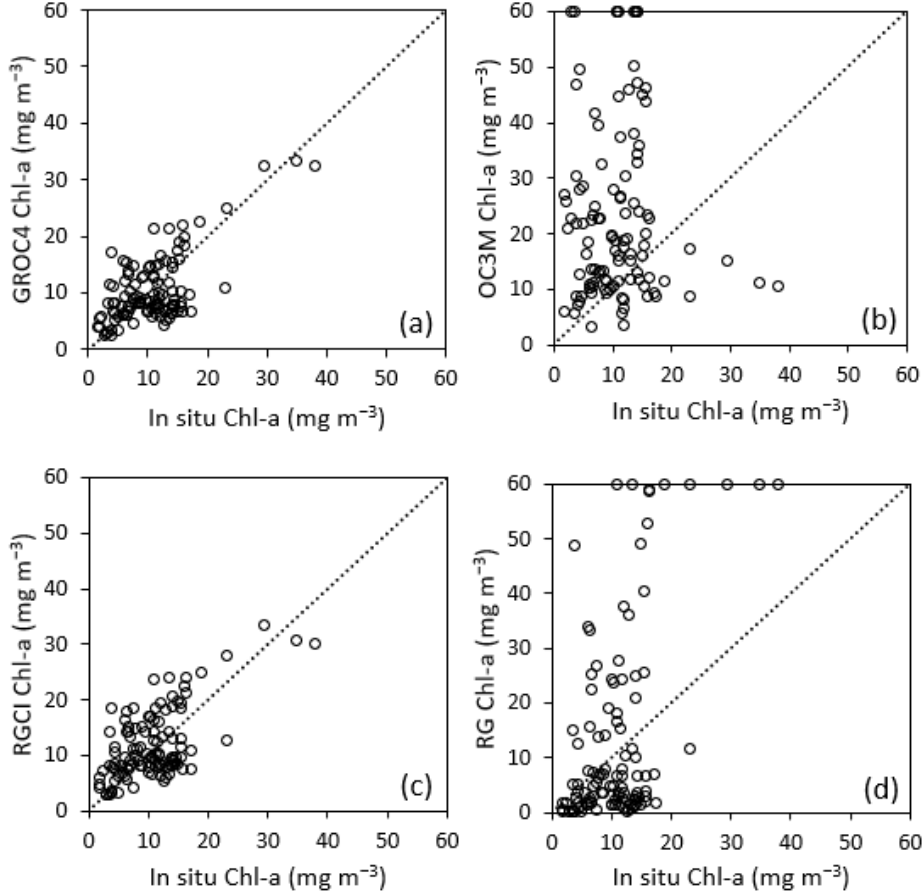
Table 4. Coefficients of the OC3M and GROC4 algorithms.